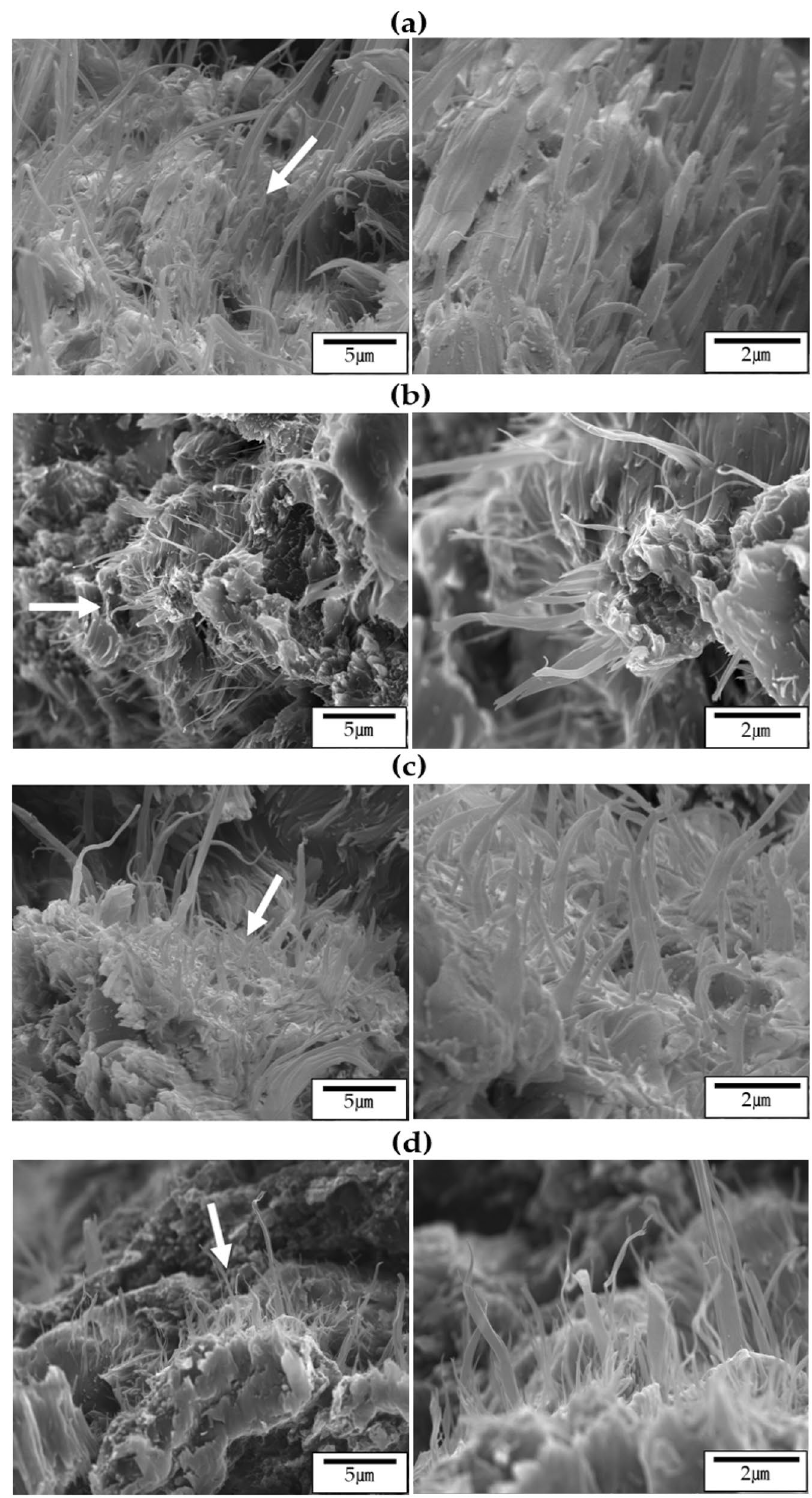
Figure 8. SEM micrographs of TLCP fibers with various heat treatment times: ( a ) 230/3, ( b ) 230/6, ( c ) 230/9, and ( d ) 230/12. Micrographs with increasing magnification levels from left to